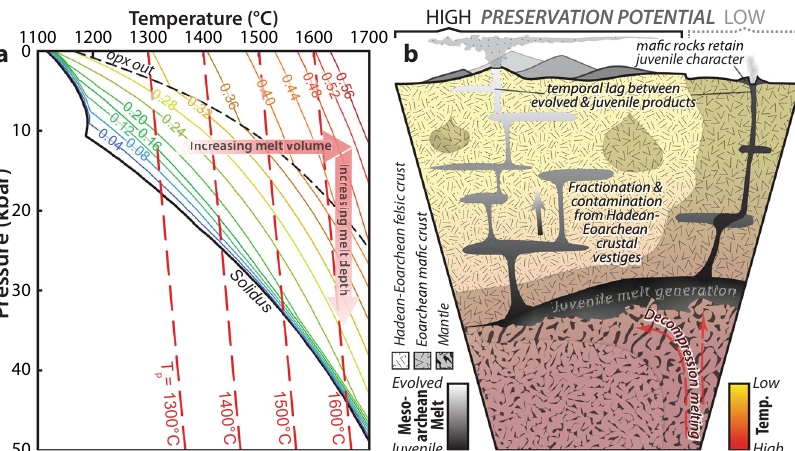
was used as the primary reference material for Hf isotope ratios, with a 176 Hf/ 177 Hf ratio of 0.282507 ±0.000006 59 . Corrected 176 Lu/ 177 Hf ratios were determined through processing against R33 zircon reference (0.001989 ±0.000869; ref. 60 ). 91500 (0.282305 ±0.000006; ref. 61 ), FC1 (0.282184± 0.000016; ref. 59 ), GJ-1 (0.282000 ±0.000005; ref. 62 ), and Ple š ovice (0.282474± 0.000012; ref. 50 ) were used as secondary references to monitor accuracy of data processing. During the analytical session, all analyzed secondary references had statistically signi fi cant means (i.e., p >0.05) that fell within 2 σ error of reported 176 Hf/ 177 Hf values (Supplementary Data 3), including 91500 (0.282288 ± 0.00011), FC1 (0.282172± 0.000009), GJ-1 (0.282011± 0.000009), and Ple š ovice (0.282474 ± 0.000013). The stable 178 Hf/ 177 Hf and 180 Hf/ 177 Hf ratios for Mud Tank yielded values of 1.467201 ± 0.000011 and 1.886829± 0.000014, respectively, which overlap at 2 σ with recommended values reported by Thirlwall and Anczkiewicz 63 (Supplementary Data 3). Decay constants, chondritic uniform reservoir (CHUR), and depleted mantle values are taken from Söderlund et al. 64 , Bouvier et al. 65 , and Grif fi n et al. 66 , respectively. Epsilon notation Hf isotopic data relative to CHUR at the initial time of crystallization [ ε Hf i ] were computed for concordant zircon grains using the age of the crystal, and the measured (present-day) 176 Lu/ 177 Hf and 176 Hf/ 177 Hf values. Elevated Yb content may have a deleterious effect on isobaric interference correction of 176 Hf/ 177 Hf. However, the median Yb content of stream sediment zircon is 2200 ppm on 176 Hf, which is less than that in reference material FC1. FC1 reproduces the expected 176 Hf/ 177 Hf ratio yet has, on average, much greater Yb interference (4000 ppm on 176 Hf) than the sample material.